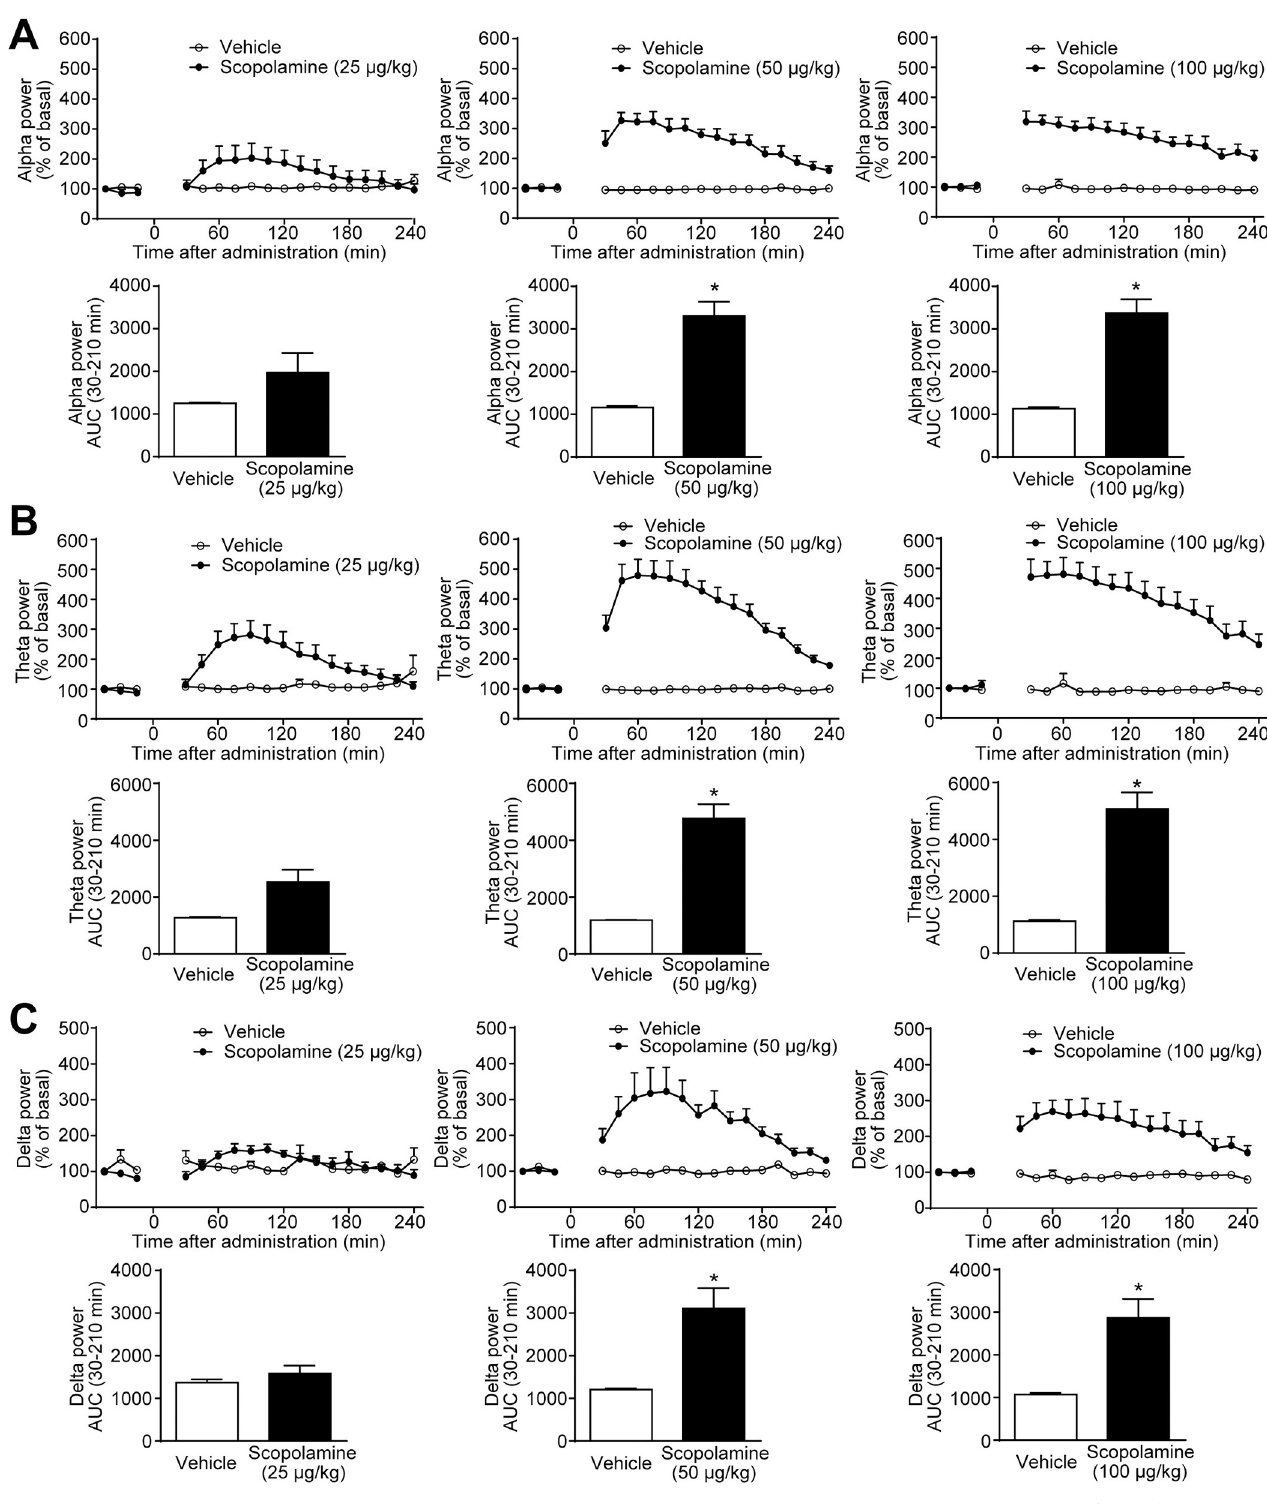
Fig 1. Scopolamine caused increases in alpha, theta, and delta power bands of the qEEG spectra, in a dose-dependent manner. Scopolamine (25–100 μ g/ kg) was subcutaneously administered to cynomolgus monkeys. After treatment with scopolamine or vehicle, (A) alpha, (B) theta, and (C) delta power bands of qEEG spectra were measured from 30 to 240 min. Results represent mean ± SEM of AUC between 30 and 210 min after treatment for 4 monkeys in each group. � P � 0.05 versus vehicle-treated group by paired t -test. AUC, area under the curve; qEEG, quantitative electroencephalogram; SEM, standard error of the